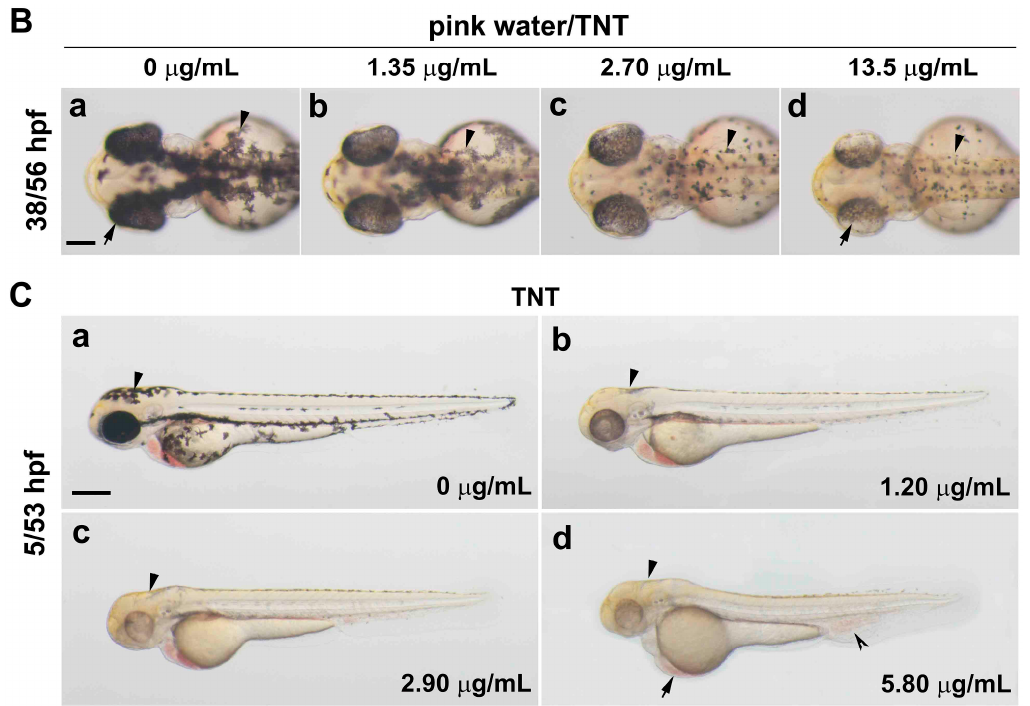
Figure 1. Trinitrotoluene (TNT) in pink water causes developmental defects in zebrafish. ( A ) Bright-field lateral view of embryos treated with pink water. Embryos were exposed to pink water containing TNT at 0 µg/mL ( a , a ′ ), 1.35 µg/mL ( b , b ′ ), 2.70 µg/mL ( c , c ′ ), and 13.5 µg/mL ( d , d ′ ) from 5 till 29 hpf ( a – d , scale bar 250 µm) or 53 hpf ( a ′ – d ′ , scale bar 500 µm) and imaged using a stereoscope. Defects in pigmentation were evident at 29 hpf ( a – d , arrow for eye color, arrowhead for body pigment, 3.2× magnification) and at 53 hpf ( a ′ – d ′ , arrow for abnormal heart, arrowhead for body pigment, 2.5× magnification). Morphological changes in body shape and a defect in blood circulation (split arrowhead) were observed in embryos treated with pink water containing 13.5 µg/mL of TNT at 53 hpf ( d ′ ). 5/29 hpf, treatment starting at 5 hpf, observation at 29 hpf; 5/53 hpf, treatment starting at 5 hpf, observation at 53 hpf; ( B ) Dorsal views of embryos treated with pink water from 38–56 hpf. ( a – d ) Embryos show a dose-dependent pigmentation defect. Less pigment is visible in the eye (arrow) and trunk melanocytes (arrowhead). 8× magnification, scale bar 250 µm. 38/56 hpf, treatment starting at 38 hpf, observation at 56 hpf; ( C ) Embryos treated with TNT at 0 µg/mL ( a ), 1.20 µg/mL ( b ), 2.90 µg/mL ( c ), and 5.80 µg/mL ( d ) from 5 hpf had similar phenotypes to embryos treated with pink water, including pigmentation defect (arrowhead), abnormal heart (arrow), and defective blood circulation (split arrowhead). 5/53 hpf, treatment starting at 5 hpf, observation at 53 hpf, scale bar 500 µm.